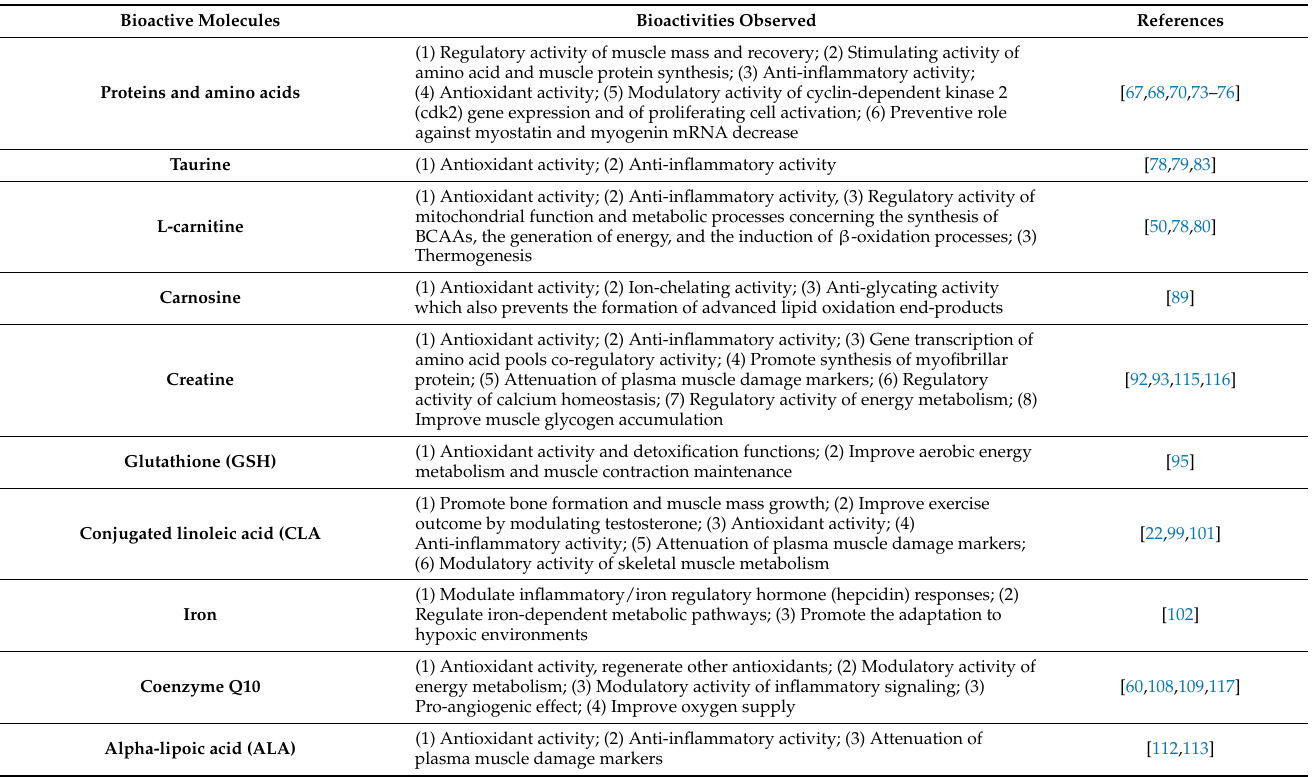
Table 3. Major biologically active meat molecules and their functions in preventing